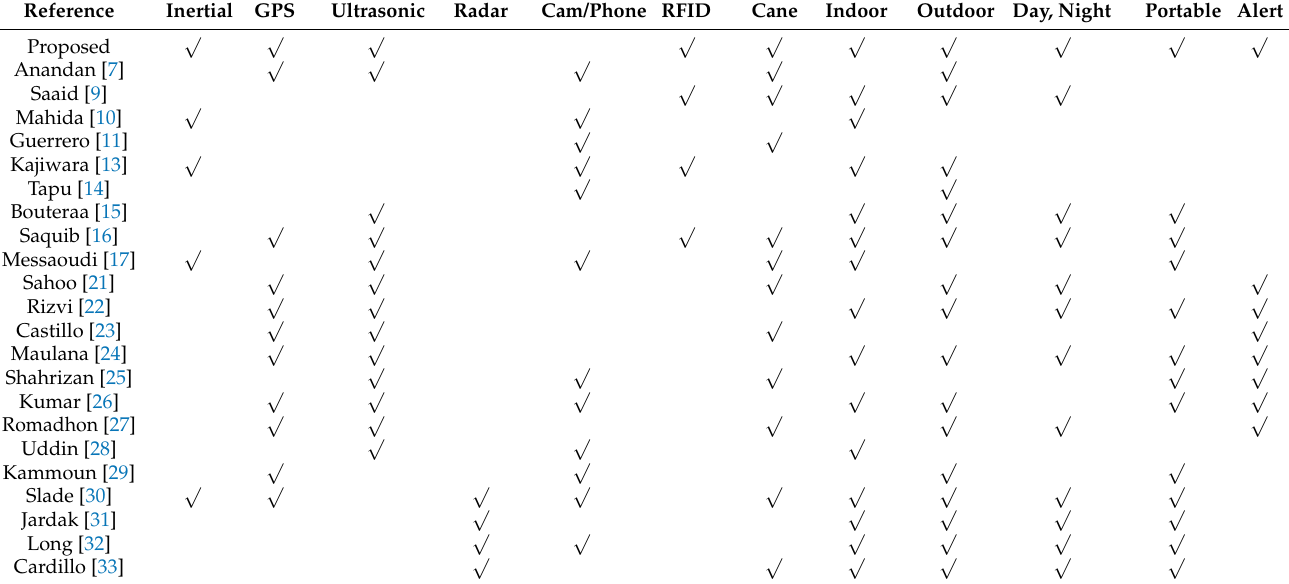
Table 1. Summary of components and features of representative electronic travel assistants for visually impaired